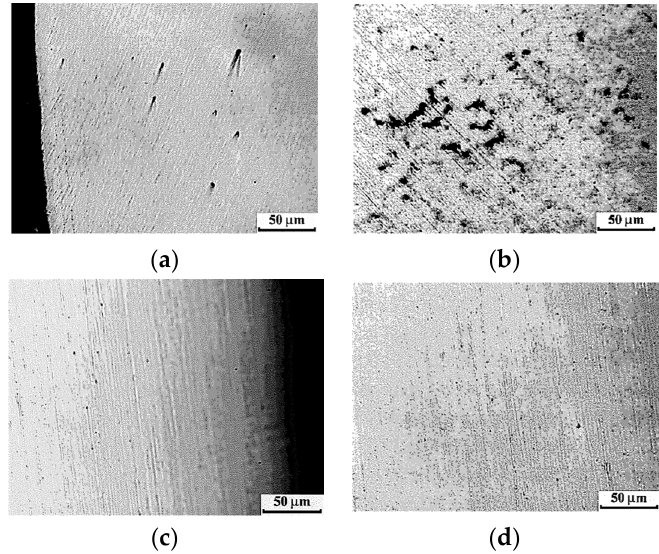
Figure 4. Microstructure of Ti-Al-Mo-V alloy in the initial state before radial forging—sample 1 ( a , b ) and after radial forging in sample 10 ( c , d ). From left to right: surface layer ( a , b ), center of the workpiece ( b , d ).